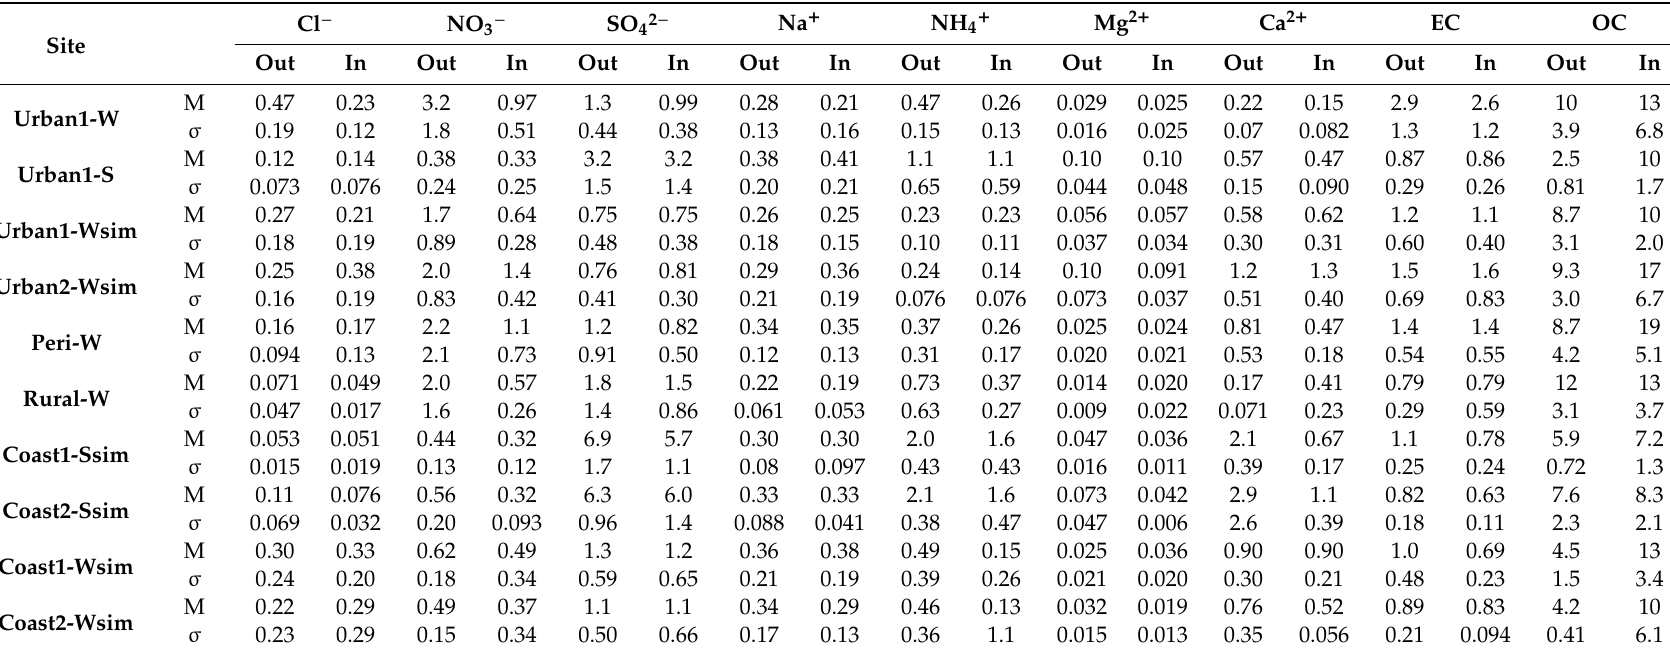
Table 5. Average mass concentrations (M) and standard deviations ( σ ) (in µ g / m 3 ) of the ions, OC ed EC measured outdoors and